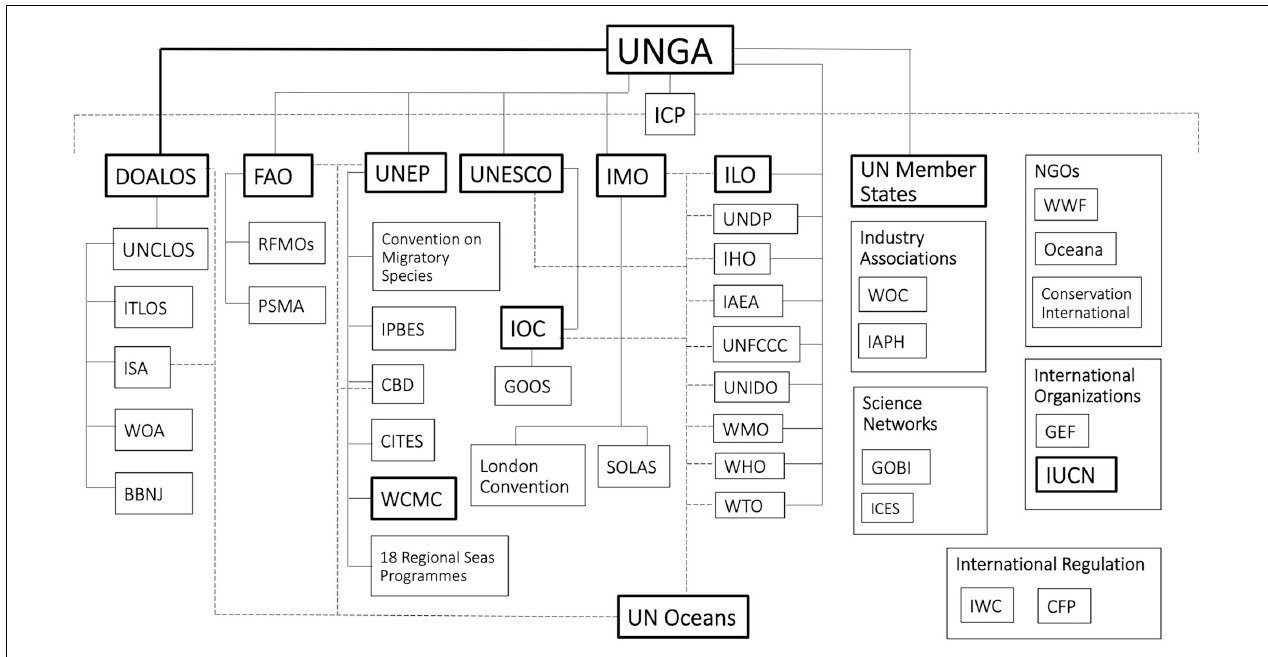
FIGURE 2 | A high-level overview of international governance mechanisms for the oceans. Please see abbreviations for a full list of the acronyms above ( Supplementary Data Sheet 1 ). Organizations and agencies formally recognized as having a prominent role in the implementation of SDG14 are bolded.